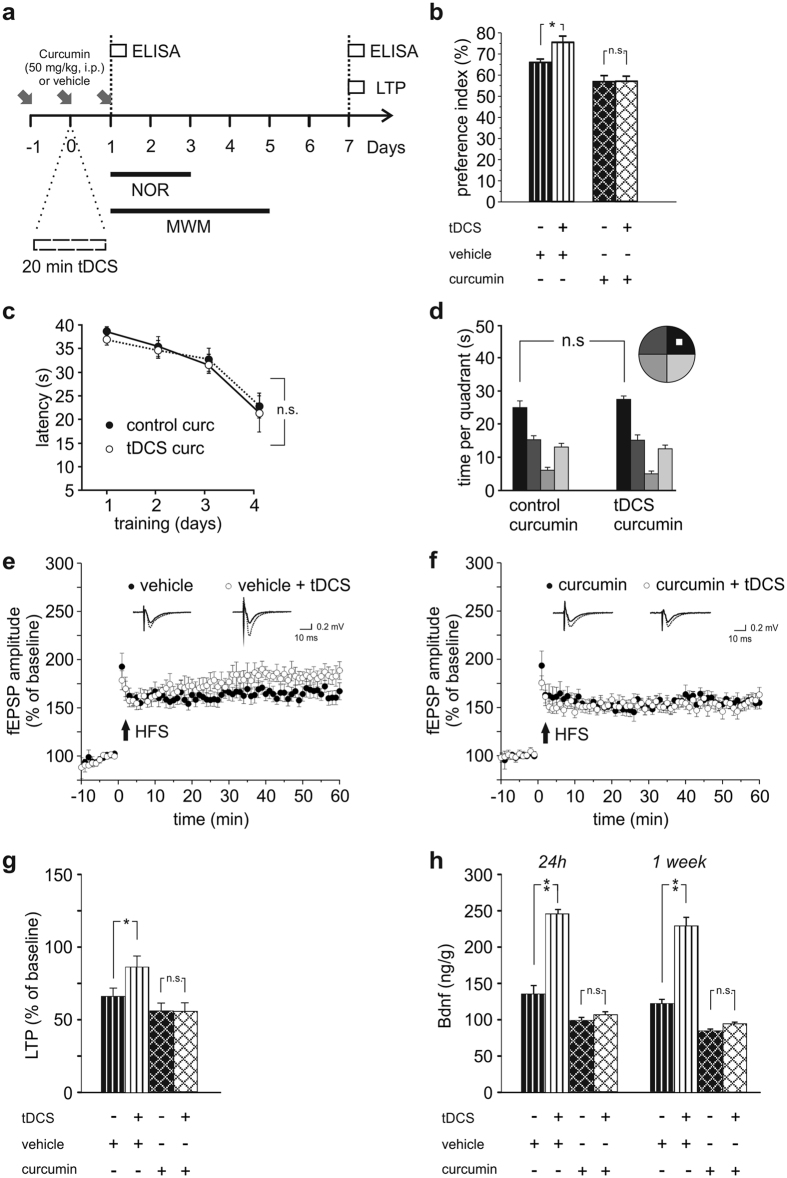
Inhibition of HAT activity hinders tDCS effects.(a) Schematic representation of the time schedule of the protocol in experiments with the HAT inhibitor, curcumin. (b) Preference toward the novel object in NOR paradigm (n = 7 for both vehicle-treated control and tDCS-mice; n = 8 for curcumin controls and n = 9 for curcumin tDCS-mice). Treatment with curcumin occluded anodal tDCS enhancement of memory in the NOR test (P = 0.95 curcumin injected tDCS mice vs. their relative control, two-way ANOVA, Bonferroni post-hoc; P = 0.005, vehicle-injected tDCS-mice vs. their controls, Bonferroni post-hoc). (c) In the MWM test, the latencies to navigate to the platform (F1,45 = 0.0007, P = 0.98 for overall acquisition; two-way RM ANOVA) and (d) the time spent in the target quadrant (P = 0.51; two-way RM ANOVA, Bonferroni post-hoc) were not significantly different in sham (n = 9) and tDCS-mice (n = 8) injected with curcumin. (e,f) Time course of LTP induced at CA3-CA1 synapses by HFS delivered at time 0 in hippocampal slices from sham and tDCS-mice injected with vehicle (e) or curcumin (f). Insets show representative fEPSPs at baseline (solid line) and during the last 5 min of LTP recording (dotted line). (g) Mean amplitude of fEPSPs recorded 60 min after HFS under the experimental conditions shown in e-f. In vehicle injected-mice tDCS enhanced LTP (P = 0.02, two-way ANOVA, Bonferroni post-hoc; n = 9 slices from 4 tDCS-mice and n = 12 slices from 4 control mice) whereas in curcumin-injected mice tDCS did not cause significant changes in LTP (P = 0.96, two-way ANOVA, Bonferroni post-hoc; n = 9 slices from 3 tDCS-mice and n = 9 slices from 3 control mice). (h) Curcumin treatment prevented tDCS-induced increases in Bdnf protein levels quantified 24 h and 1 week after tDCS (P < 0.001 vehicle-injected tDCS mice [n = 4] vs. their respective control [n = 4]; P = 0.4 curcumin-injected tDCS mice [n = 4] vs. their respective control [n = 4]; two-way ANOVA, Bonferroni post-hoc). Data reported in the first two columns at both time points are the same shown in Fig. 5c. Data are expressed as mean ± s.e.m. *P < 0.05, **P < 0.001.